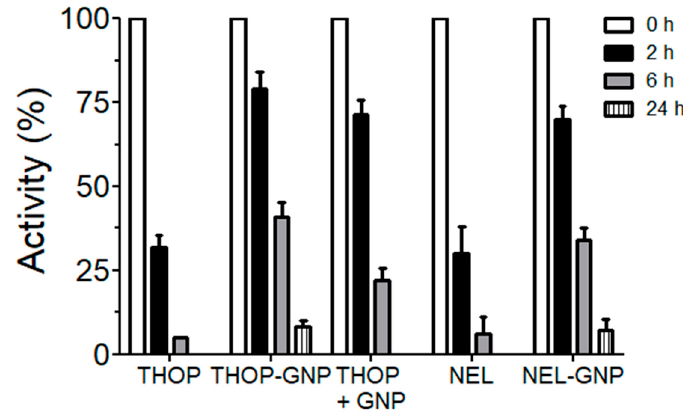
Figure 10. Increased activity based on stability of rTHOP-GNP and rNEL-GNP. Both THOP and NEL enzyme ultimately lose their activity after 6 h in solution at room temperature. When immobilized in the gold nanoparticles, the maintenance of activity is notable. GNP synthesized without any protease (HEPES-GNP) and incubated with in solution THOP was also capable of retaining THOP proteolytic activity. Samples were prepared and data obtained as described in the Material and Methods section.